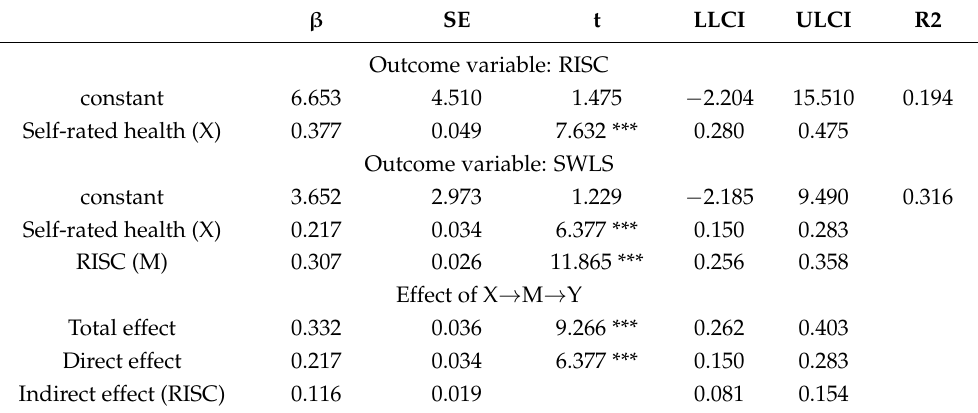
Table 3. Mediation analysis results about the effect of self-rated health on life